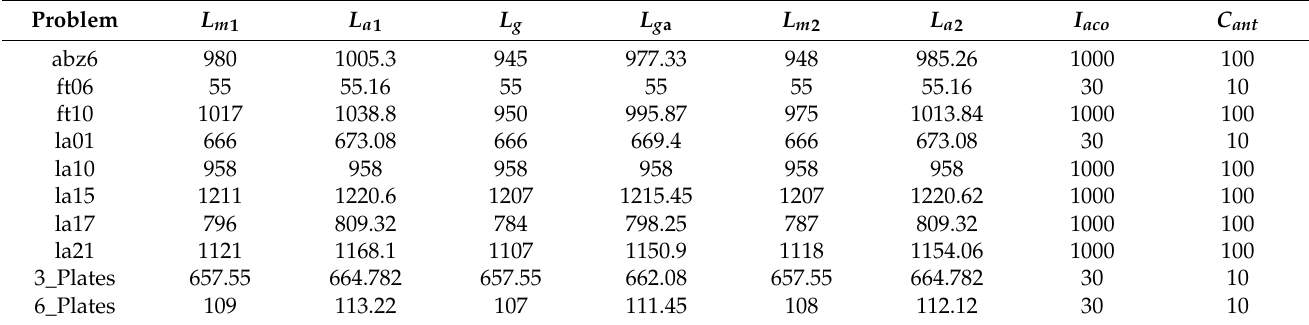
Table 2. Examples of the best sets of coefficients obtained using the genetic algorithm.